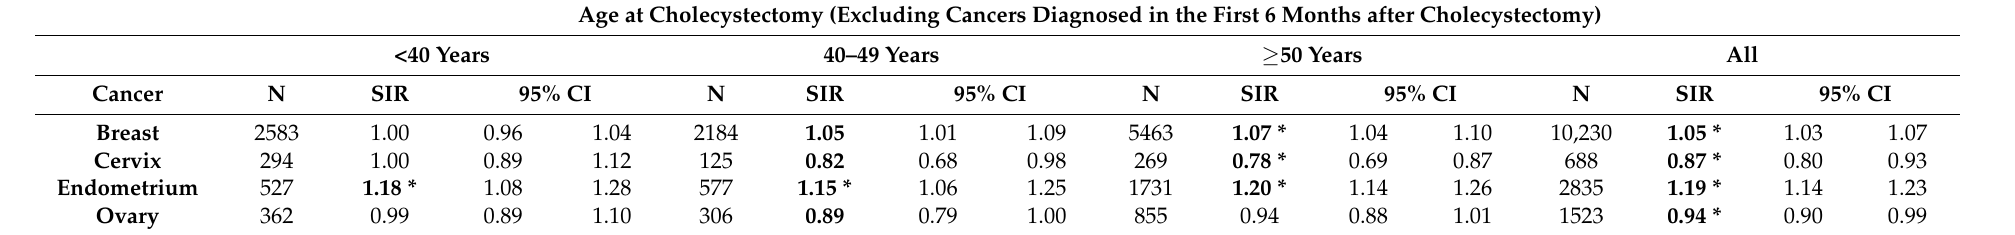
Table 2. Relative risk of female cancers by age at cholecystectomy. Cancers diagnosed in the first 6 months after cholecystectomy are excluded. Age at Cholecystectomy (Excluding Cancers Diagnosed in the First 6 Months after